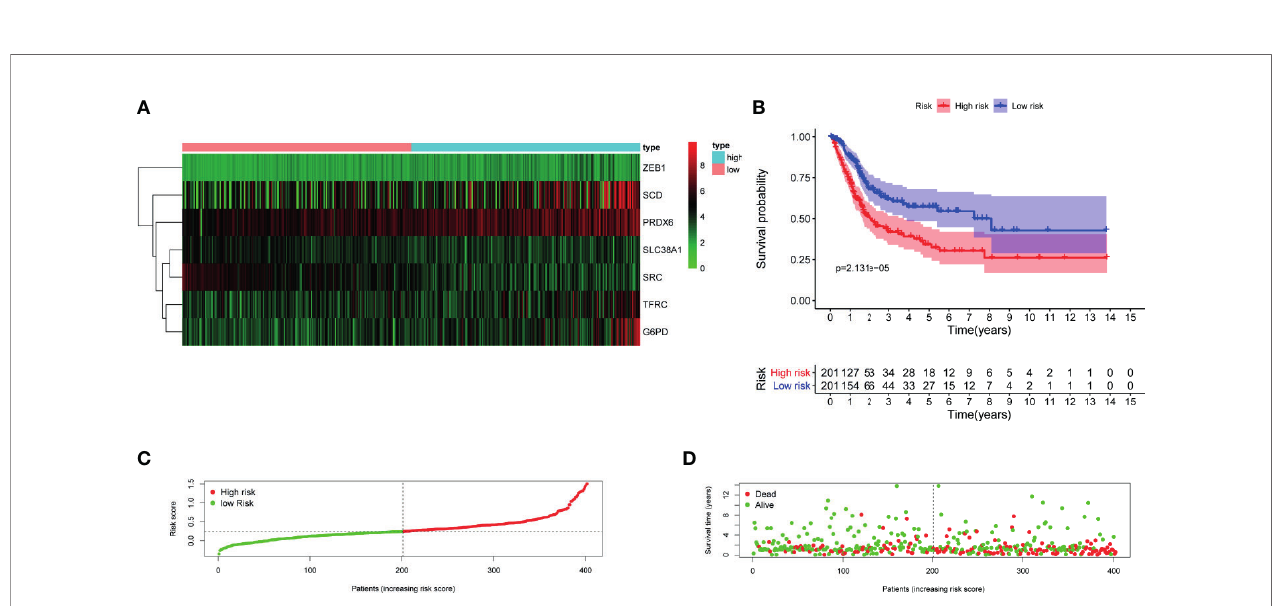
FIGURE 4 | Evaluation of the constructed FRG prognostic signature in TCGA – BLCA cohort. (A) Heatmap of seven genes expression between high- and low-risk score group in TCGA – BLCA cohort. (B) Kaplan – Meier survival curve. (C) Risk score curve plot. The dotted line indicates the individual distribution of risk score, and the patients are categorized into low-risk (green) and high-risk (red) groups. (D) Risk score scatter plot. Red dots indicate the dead patients, and green dots indicate the alive. With the increase in risk score, more patients died. FRG, ferroptosis − related gene; TCGA, The Cancer Genome Atlas; BLCA, bladder